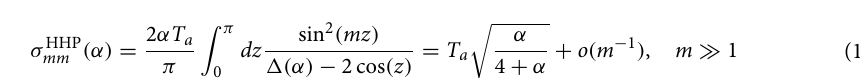
Figure 3. ( a ) Spatial correlation function calculated via Eq. (4). The entries of 1 and diagonalising A . The parameters of the system are: L t s ˆ = ≫ 0.002, 5 condition) and α . We observe an exponential decay with a growing correlation length that turns ∈ [ ] 0 . ( b ) Scaling of the correlation length obtained from an exponential fit of ζ HHP into a power law when α = for different combinations of parameters. We can see that the relation ξ microscopic details of the system. Quasi–Toeplitz cases are discussed in the next paragraph. In both panels we 0.001 and T 0 T a used T 1 L = = =